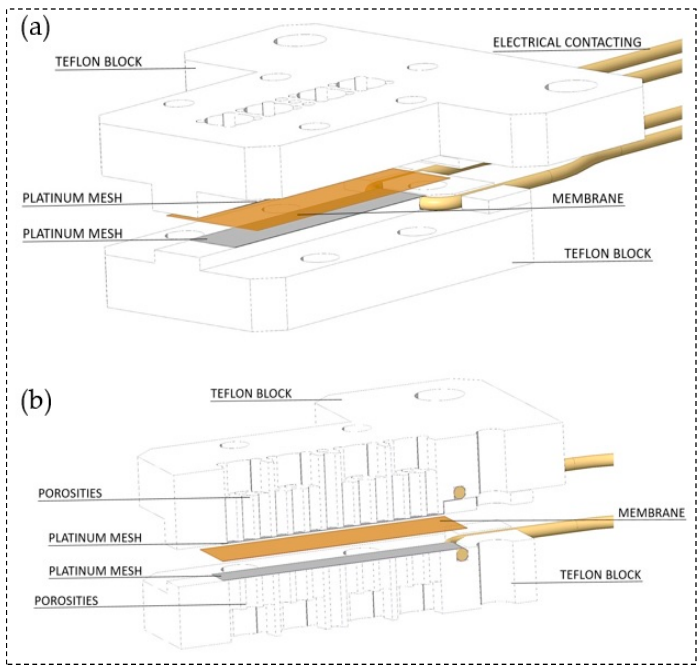
Figure 3. ( a ) Arrangement of the through-plane impedance cell and ( b ) through-plane impedance cell at cross